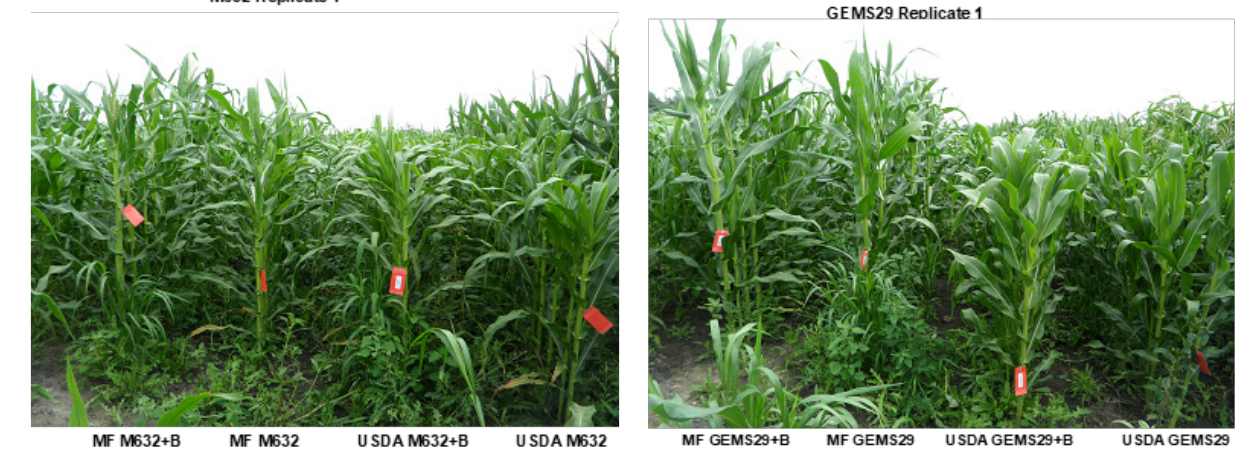
Figure 3: Picture at the top shows M632 developed in our program (MF) relative to the original USDA accession. Picture at the bottom shows GEMS 29 developed in our program (MF) relative to the original USDA accession. Pictures were taken in July. Plus B indicates seed was ino- culated with a mixture of diazotrophic